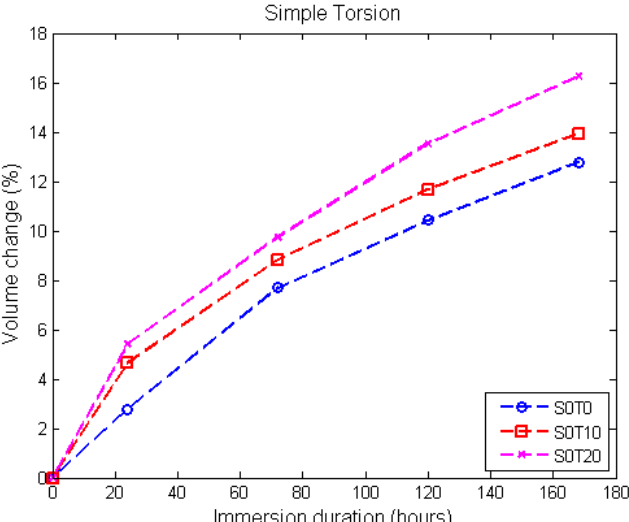
Figure 7. Volume change for different twisting